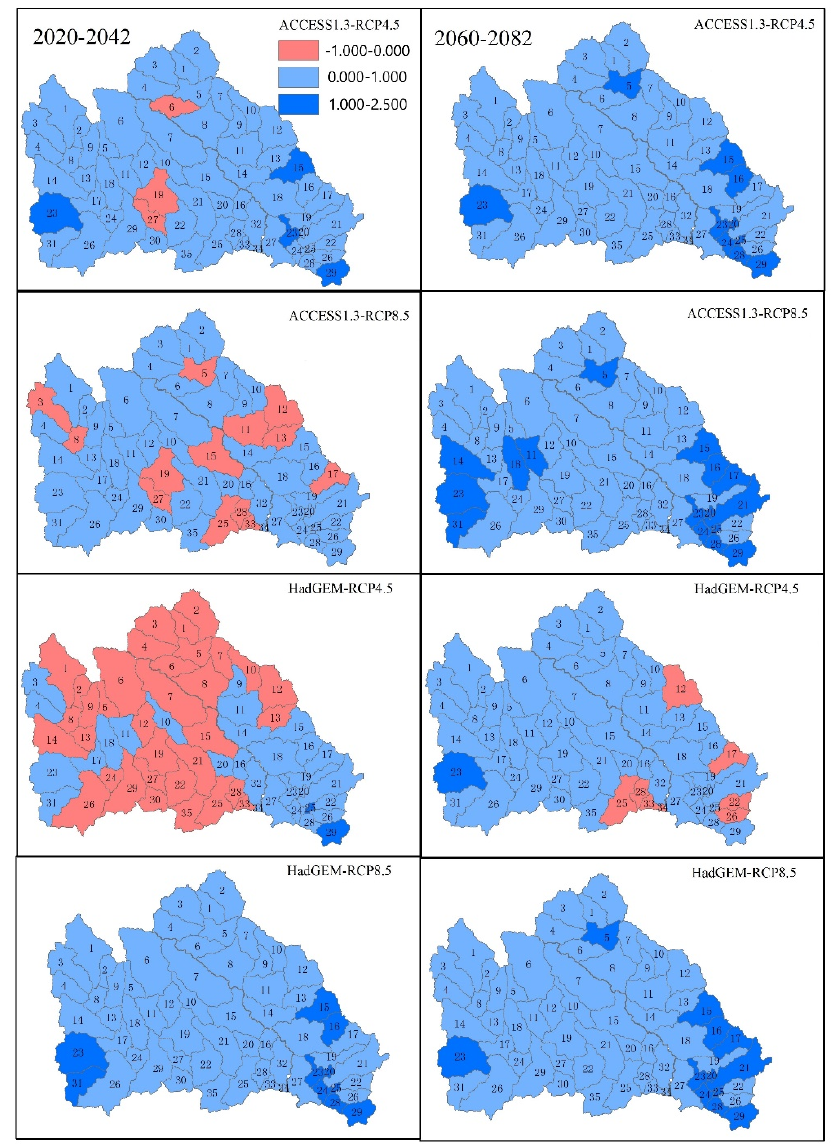
Figure 10. Spatial distribution of sediment load under different climate change projections.